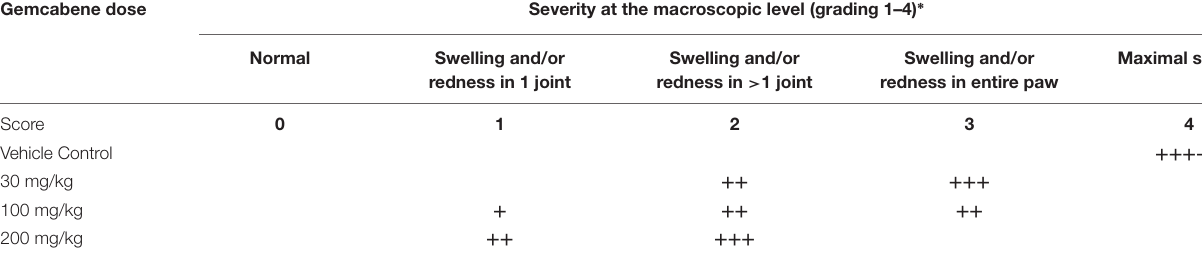
TABLE 2 | a Effect of gemcabene on severity of arthritis on day 7. Gemcabene dose